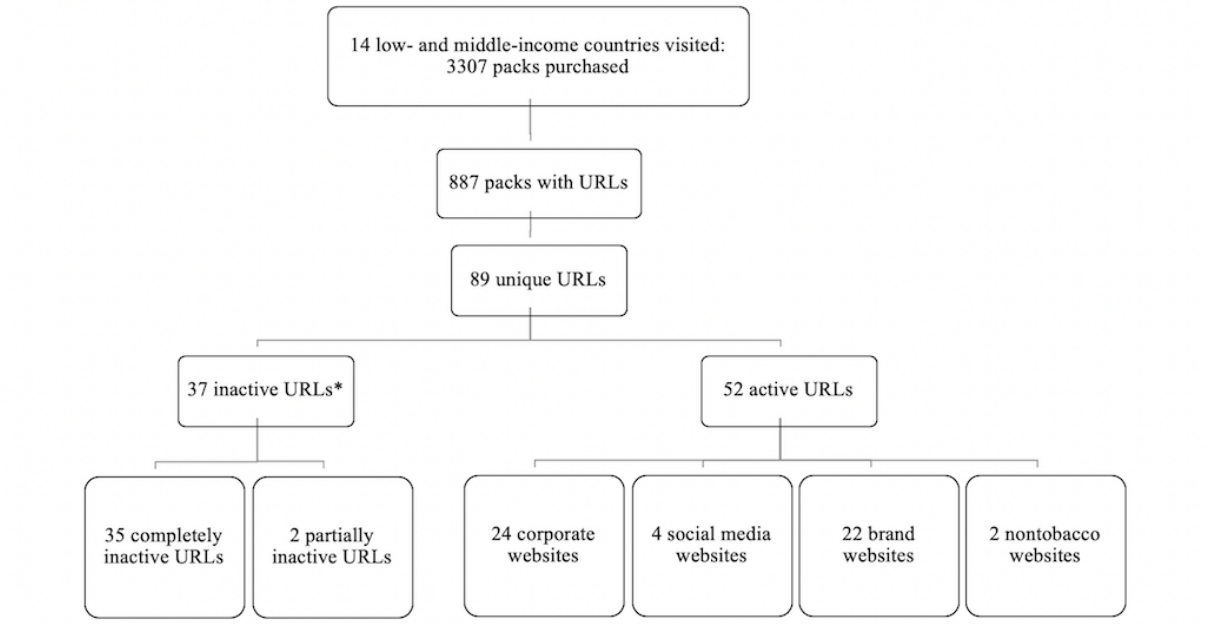
Figure 1. Breakdown of coded websites. *37 websites considered inactive for the following reasons: the page could not be found (n=17), the page took too long to respond (n=7), the site was closed for construction (n=5), the domain name had expired (n=4), some parts of the page were inactive (n=2), the company had been sold (n=1), or access was not allowed